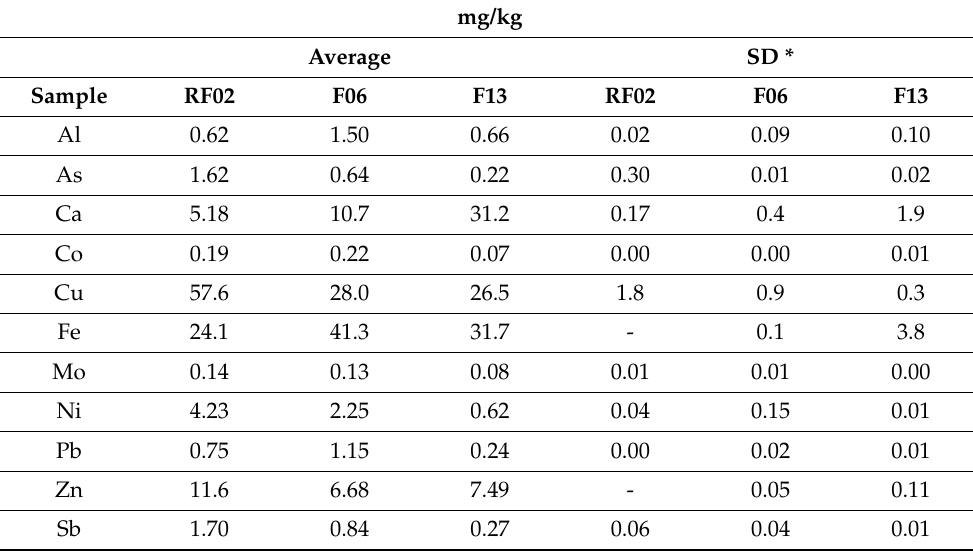
Table 4. Leaching data for leachates (mg/kg), measured according to static pH titration at pH 5 for the sample size fraction of 0.30–0.60 mm. * standard